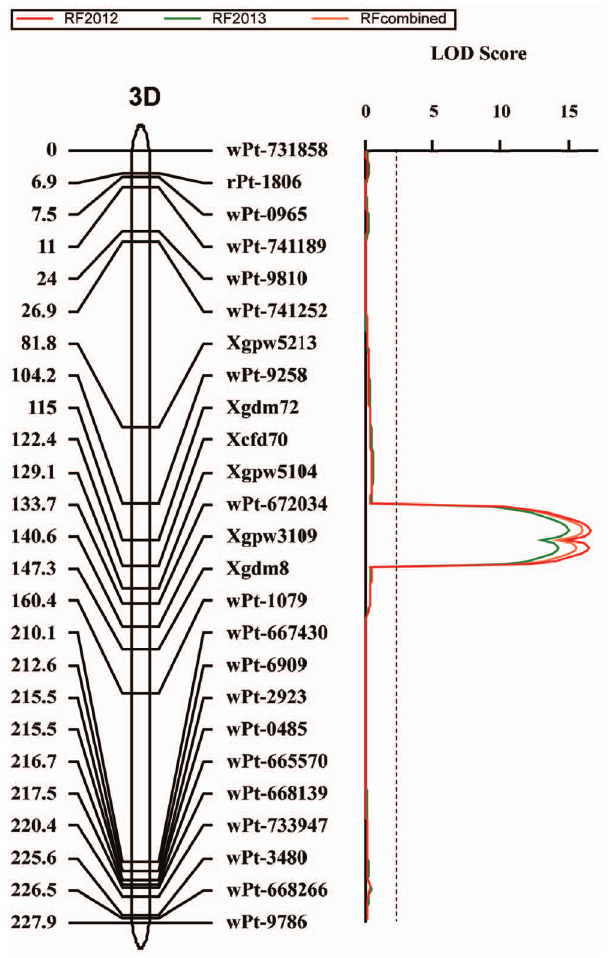
Figure 5. Quantitative trait loci (QTL) for brittle rachis. QTL detected on chromosome 3D in the Triticum aestivum ssp. tibetanum Shao population from accessions Q1028 6 ZM9023. Marker positions are shown on the right of the linkage map, and distances between loci (in centimorgans, cM) are shown on the left. The vertical dashed line indicates the significance threshold (LOD 5